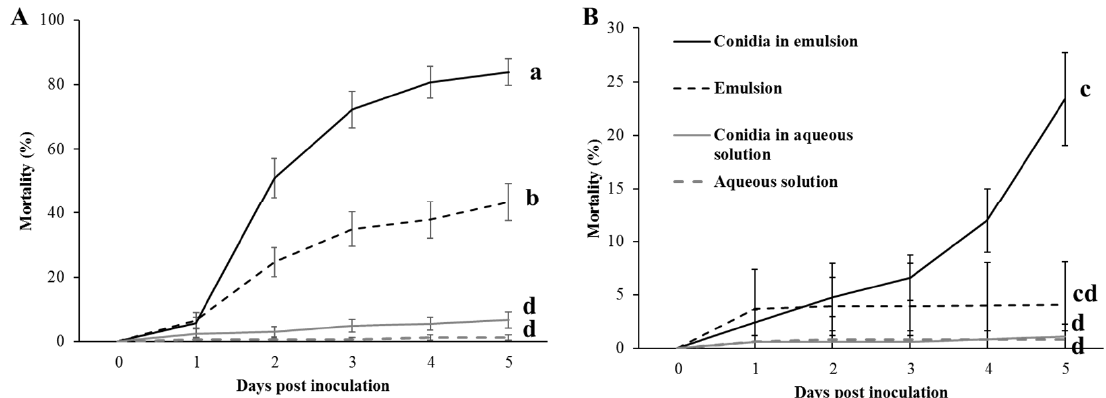
Figure 3. Mortality (% ± standard error (SE)) of larvae exposed to leaves treated with emulsion and aqueous solution (Triton-X100 0.01% v / v ), with or without conidia, at high RH ( A ) and at low RH ( B ), over a period of 5 days. Different lower-case letters designate significant difference in fifth day post-inoculation (DPI) mortality, as was tested by Tukey’s honestly significant difference (HSD, α < 0.05). Table 2. Synergism assessment based on Bliss’s model for independent joint action of chemical